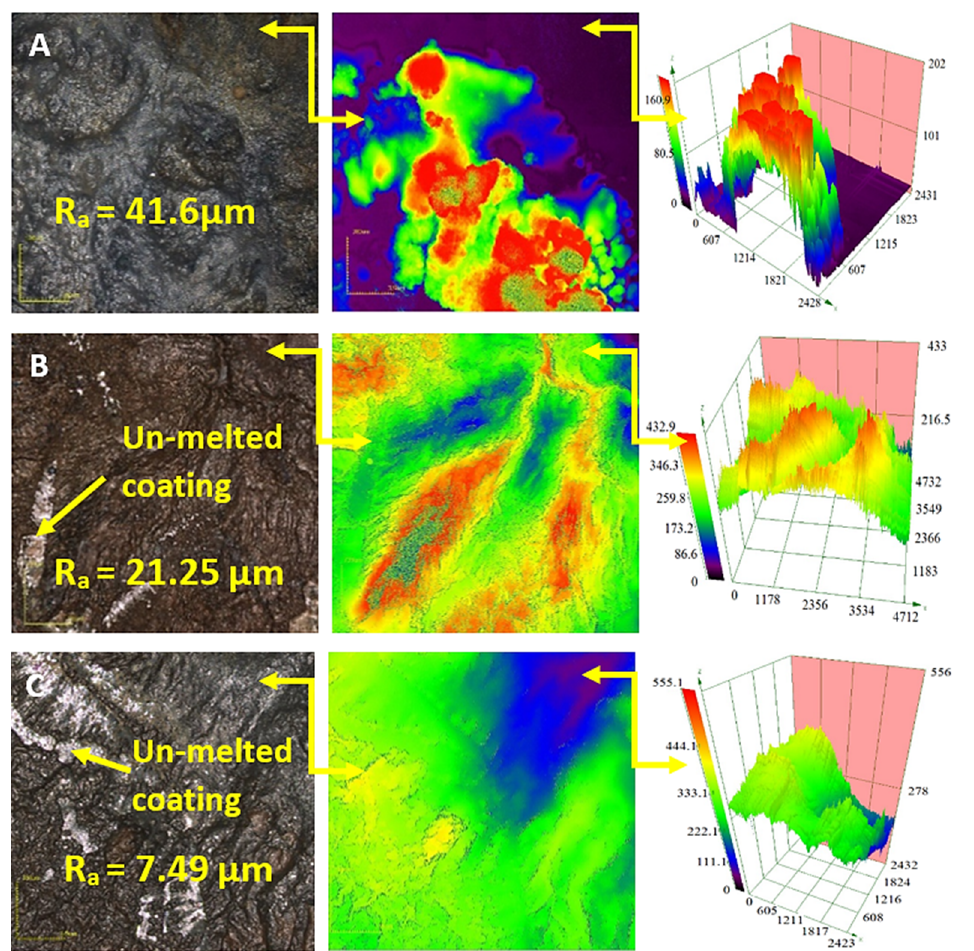
Figure 11. Confocal micrographs of the morphology of the treated Ti-6Al-4V surfaces coated with Ni / Al 2 O 3 containing 30 nm diameter TiO 2 particles as a function of ( A ) Ni / Al 2 O 3 particles, ( B ) Ni / Al 2 O 3 +30 nm TiO 2 particles and ( C ) Ni/Al 2 O 3 + 250 nm TiO 2 particles.